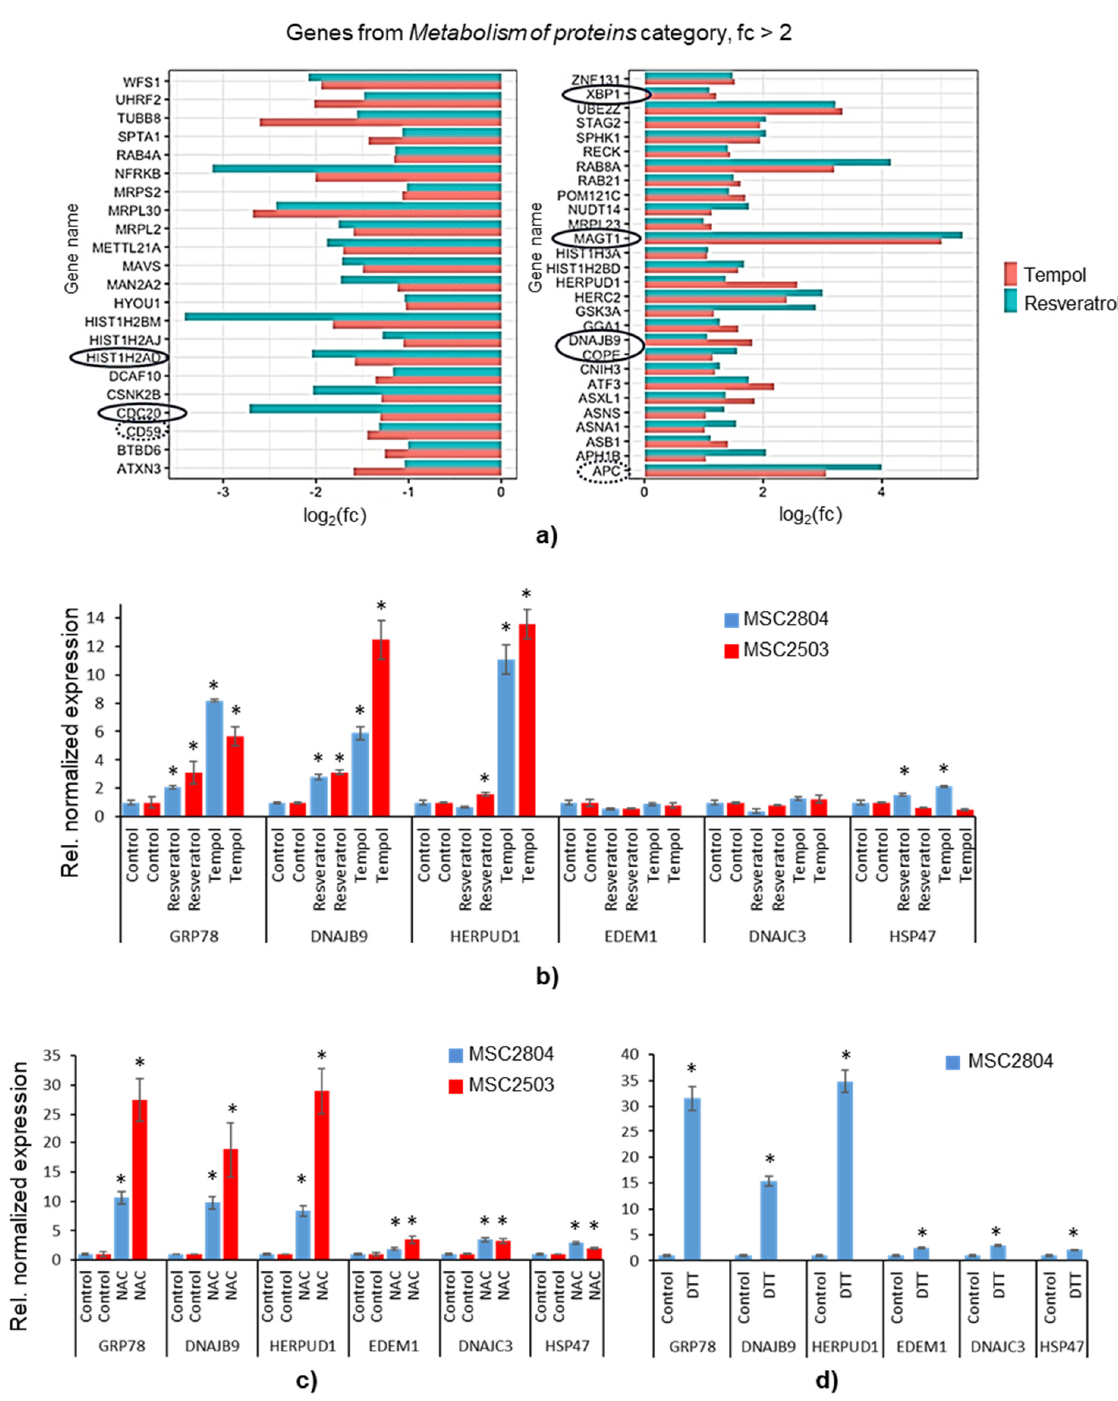
Figure 5. High-dose AO treatments induce ER stress and UPR: ( a ) sets of up- and down-regulated by both Tempol and resveratrol genes in the category Metabolism of Proteins with the fold change exceeding 2; significantly ( p -value ≤ 0.1, Bonferroni correction) altered genes are marked; ( b – d ) Induction of ER stress and UPR marker genes upon MSC exposure to Tempol and resveratrol ( b ), NAC ( c ), DTT ( d ); the expression levels of the indicated genes were determined by real-time qPCR, normalizing against Actin expression, and calculated as fold difference from the control values; RNA was extracted from different MSC lines: MSC2804 (used throughout the study, blue color) and MSC2503 (red color). Data ( b – d ) are shown as mean ± SD. Two-tailed Students t-test was utilized for pairwise comparison. * p < 0.05 vs. corresponding control. Abbreviations: fold change of gene expression in Tempol- and resveratrol-treated cells (fc); endoplasmic reticulum (ER); unfolded protein response (UPR); dithiothreitol (DTT), N-acetyl-L-cysteine; (NAC); human mesenchymal stem cells (MSCs); lines#2804 and 2503.